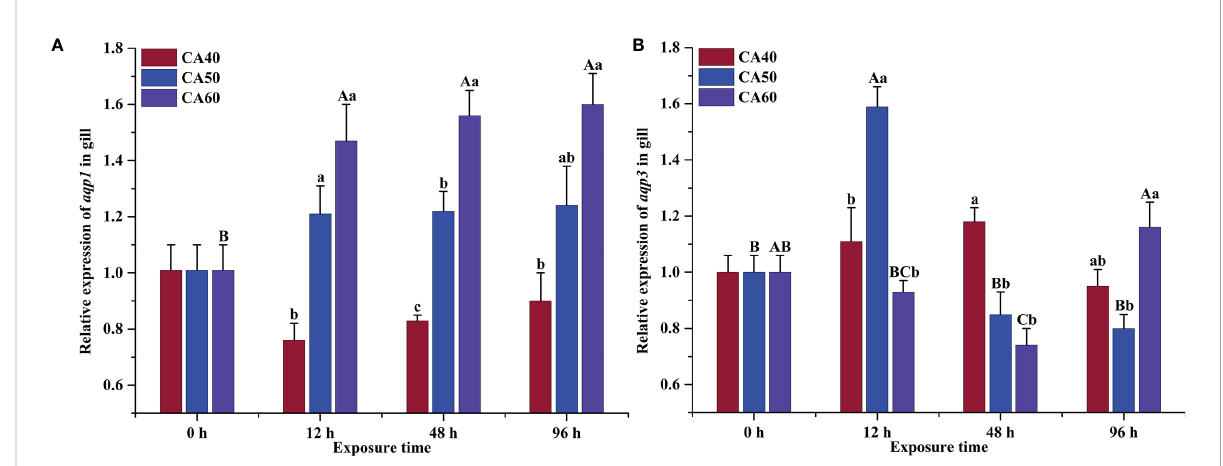
FIGURE 2 Effects of carbonate alkalinity (CA) on the relative expression of aqp1 (A) and aqp3 (B) in the gills of large-scale loach. The different capital letters are signi fi cant differences among the different exposure times in the same CA concentration. The different lowercase letters are signi fi cant differences among the different CA concentrations at the same exposure time. The bars represent the mean ± S.E. (n =